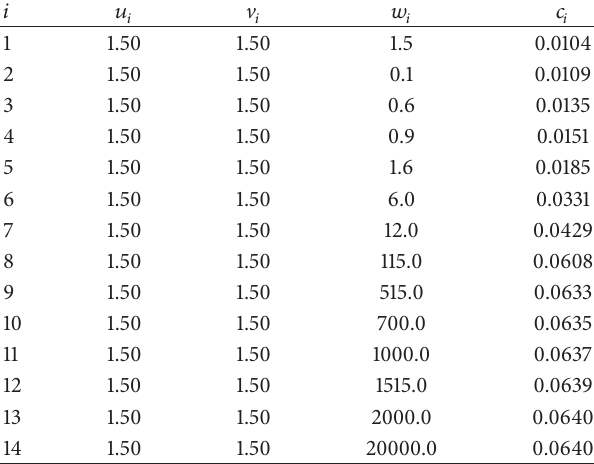
Table 12: Values of 𝑐 𝑖 for various values of shape parameters 𝑢 𝑖 , V 𝑖 , and 𝑤 𝑖